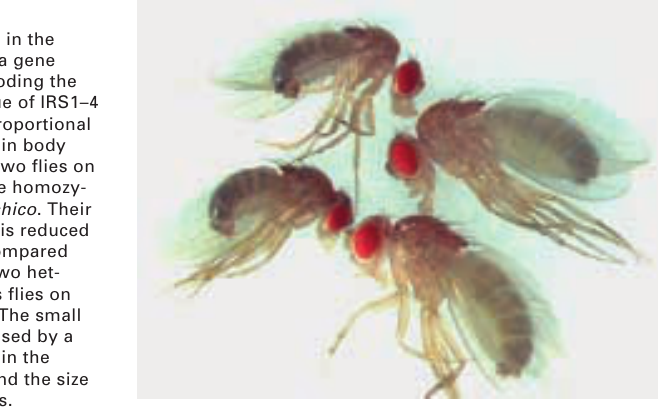
Mutations in genes involved in growth regulation are identified in the pinhead/big- headscreen. The fly in the middle is wild-type and displays a normal head size. The fly on the left is a genetic mosaic. It is homozygous for a growth inhibiting mutation in the head and heterozygous for the same mutation in the rest of the body. As a con- sequence, the size of the head is reduced (pinhead), yet bristles and eyes are differen- tiated normally. The head of the fly on the right is homozygous for a mutation in the tumour suppressor gene PTEN. Because of the lack of this growth inhibitor, head size is increased. Mutant flies with these phenotypes are selected, the mutated genes are mapped and molecularly